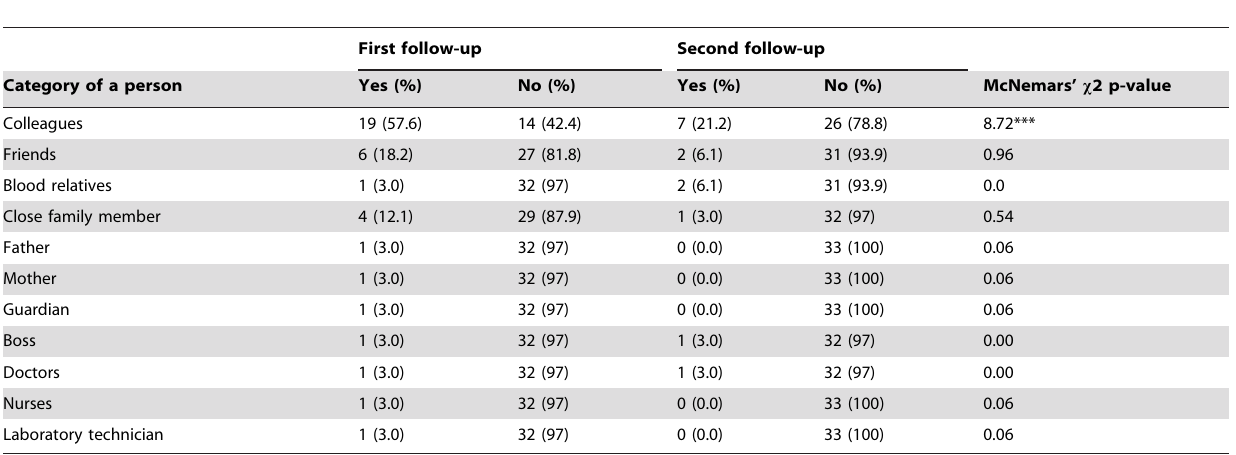
Table 4. Negative comments/reactions from various people about participants’ involvement in an HIV vaccine